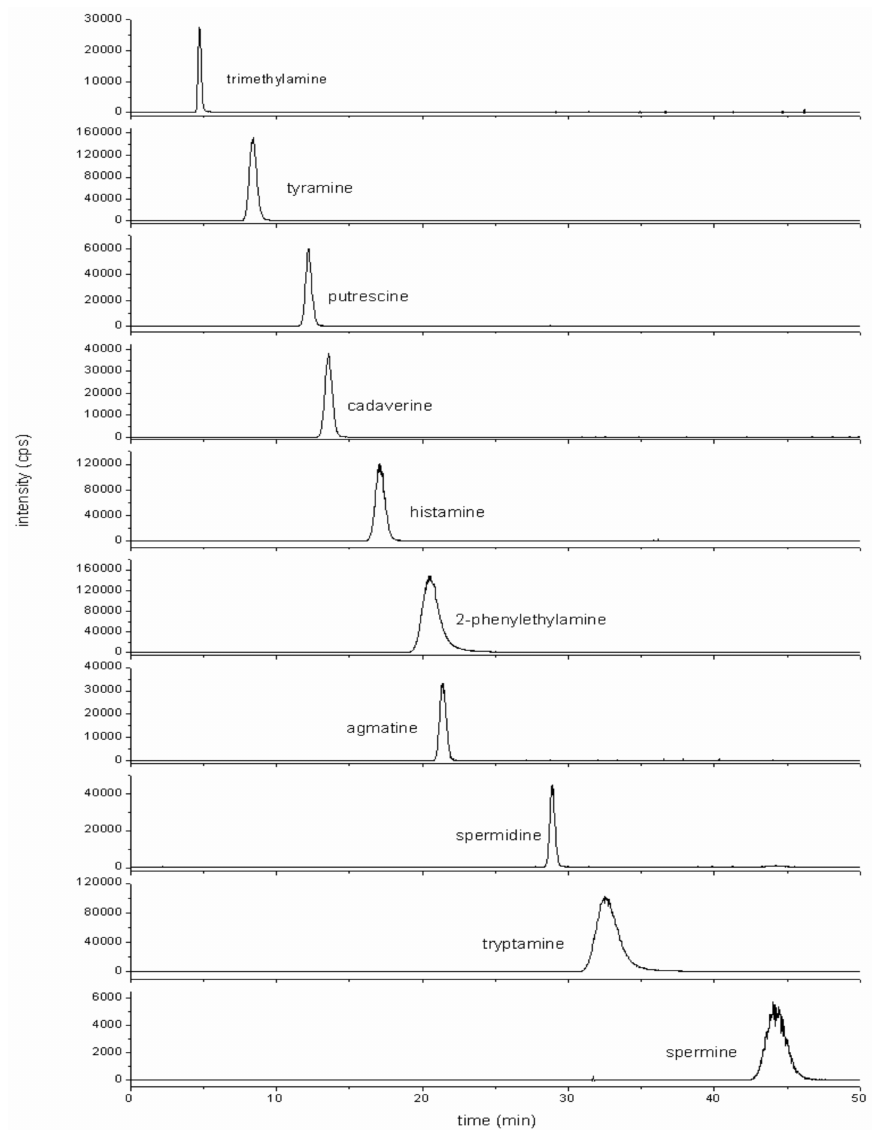
Figure 1. MRM chromatograms of standard mixture of biogenic amines. Concentration of each of the amines was 10 mg L − 1